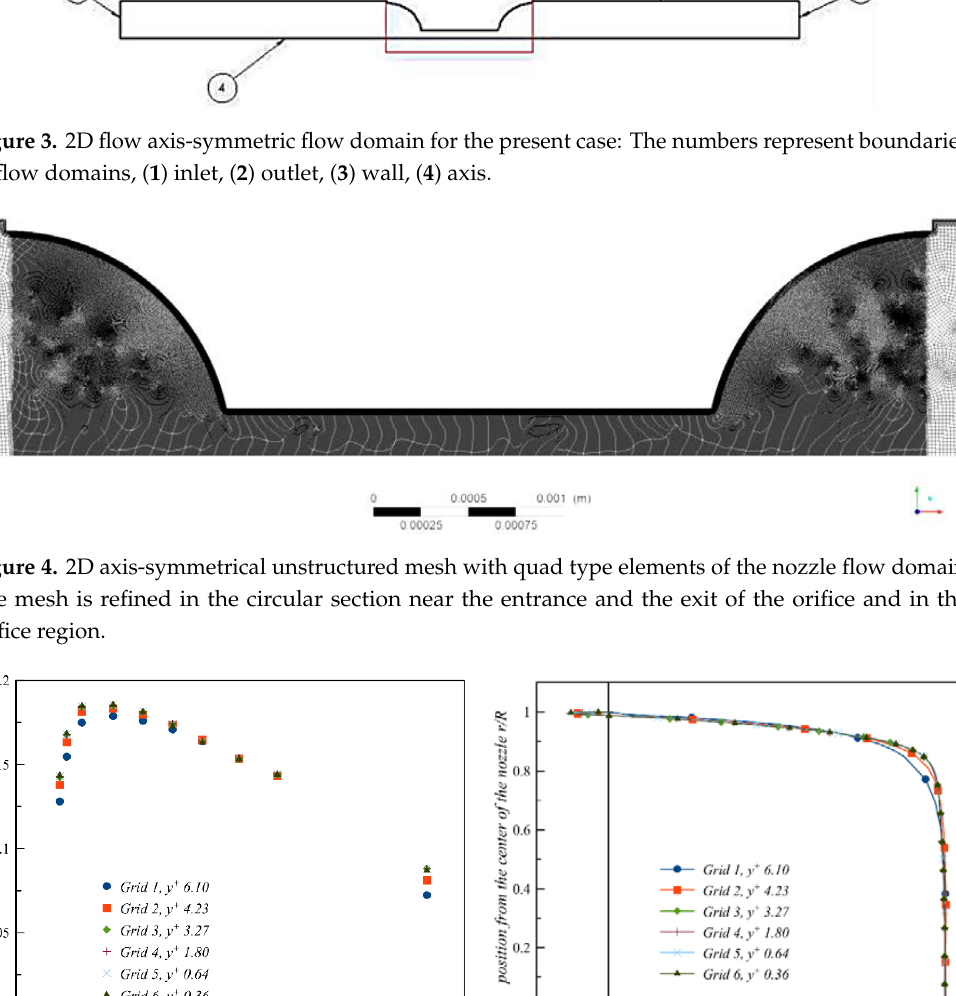
Figure 5. Grid sensitivity study: ( a ) vapor volume fraction across the nozzle at different axial positions along with the nozzle, ( b ) axial velocity distribution at x/L = 0.0167.